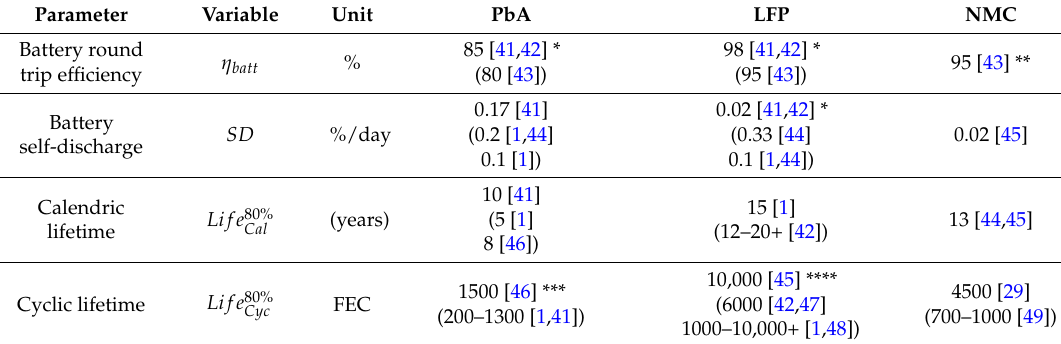
Table A1. Literature review for battery performance parameters used in this study. For all table fields the value used for simulations is given first. In some cases, other values are given in brackets—these are for information to the reader only, but not further used in the